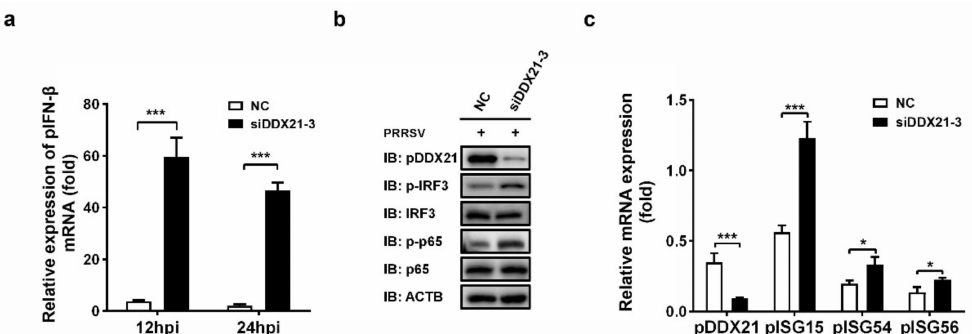
Figure 8. pDDX21 downregulates IFN- β by impairing the activation IRF3 and p65 during PRRSV infection. ( a ) iPAM cells were transfected with siDDX21-3 or NC for 24 h and then infected with PRRSV (MOI = 0.5). At 12 hpi and 24 hpi, the cells were collected to detect pIFN- β mRNA via qRT-PCR. ( b , c ) iPAM cells were transfected with siDDX21-3 or NC for 24 h and then infected with PRRSV (MOI = 0.5). At 24 hpi, the cells were collected for use in a Western blotting analysis with the antibodies anti-DDX21, anti-phosphorylated IRF3, anti-total IRF3, anti-phosphorylated p65, anti-total p65, or anti- β -actin ( b ) or in qRT-PCR for detecting the mRNA expression levels of pDDX21, pISG15, pISG54, and pISG56 ( c ). All experiments were performed in triplicate. The data are presented as the means ± SD of three independent experiments (* p < 0.05; *** p <